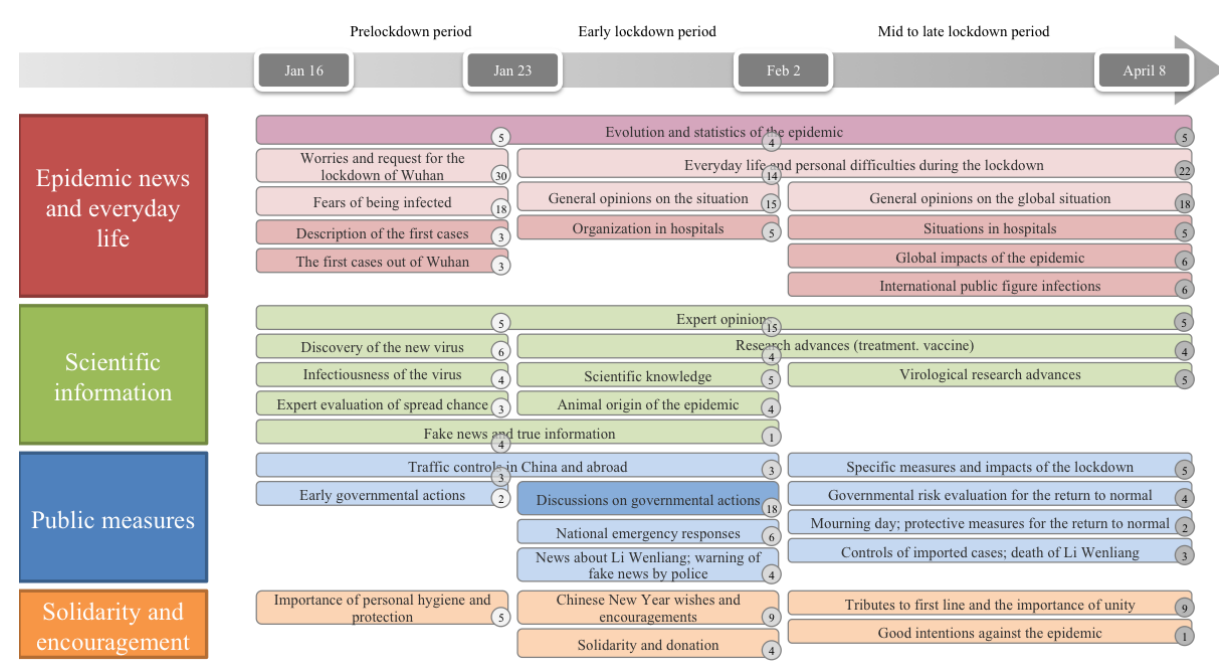
Figure 1. Topics identified on Weibo during the three periods. All topics are colored according to the category and aligned for the three periods. The factual topics are colored in dark red and dark blue, and the subjective topics are colored in light red and light blue for the first and the third category, respectively. The percentage of each topic is indicated in a circle at the bottom right.